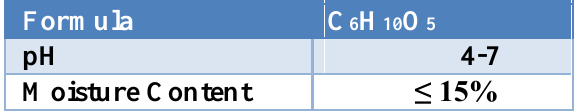
Table, 3: Properties of starch according to the product company